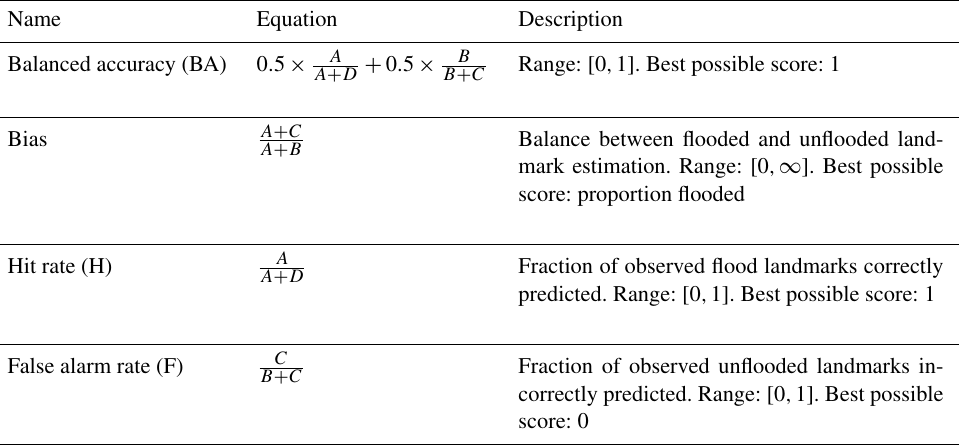
Table 3. Metrics used to evaluate the algorithm’s performance. A, B, C and D respectively correspond to true flooded (landmark flooded predicted as flooded), true unflooded (landmark unflooded predicted as unflooded), false flooded (landmark unflooded predicted as flooded) and false unflooded (landmark unflooded predicted as